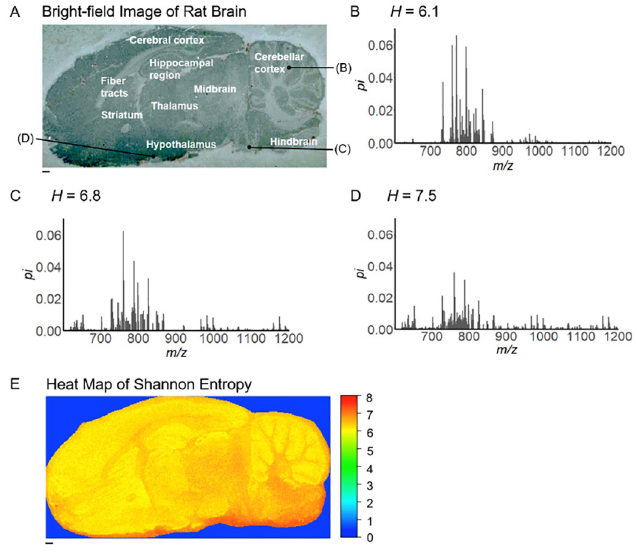
Fig 1. Shannon entropy calculated from the mass spectrum. ( A ) The bright-field image of the sagittal rat brain using MALDI-FT-ICR-MSI with 2,5-dihydroxybenzoic acid (DHB) matrix [20]. ( B-D ) Mass spectra at three different spots on the rat brain ( p i : relative mass spectral intensity). At these spots, Shannon entropy values were 6.1 ( B ), 6.8 ( C ), and 7.5 ( D ), respectively. ( E ) The heat map of the Shannon entropy from the rat brain. The scale bar denotes 1 mm.